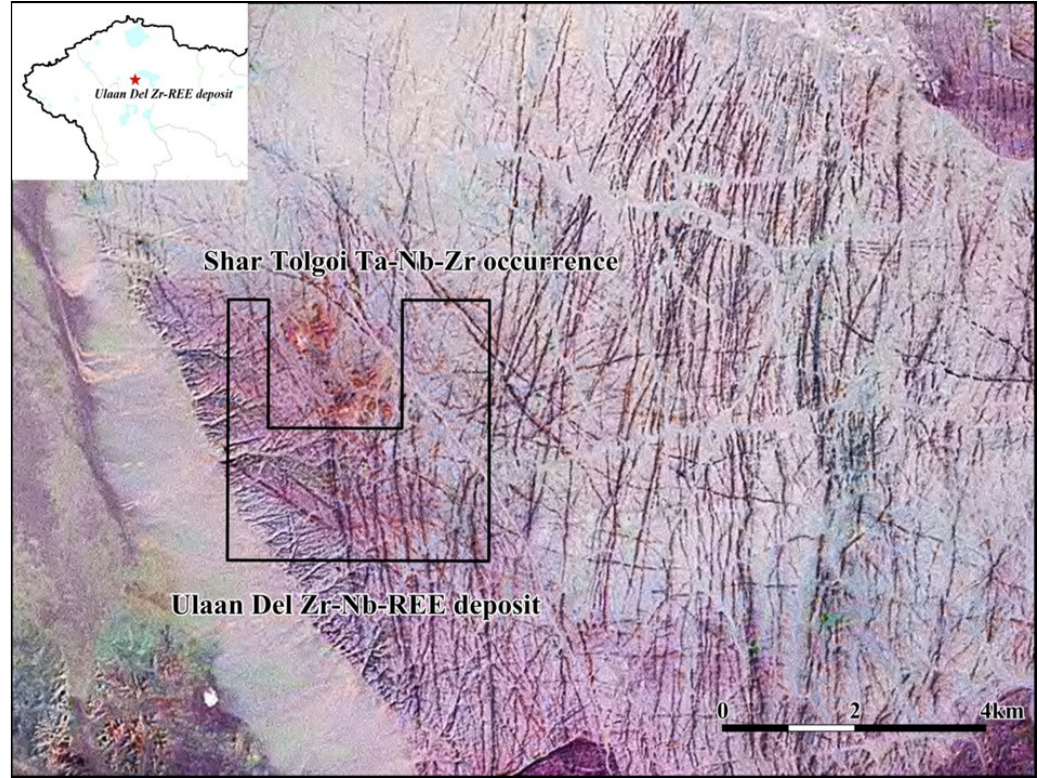
Fig. 2. Landsat image of the Ulaan Del Zr-Nb-REE deposit area. Location of the Shar Tolgoi Ta- Nb-Zr occurrence and the distribution of the ore-bearing alkaline dykes in the